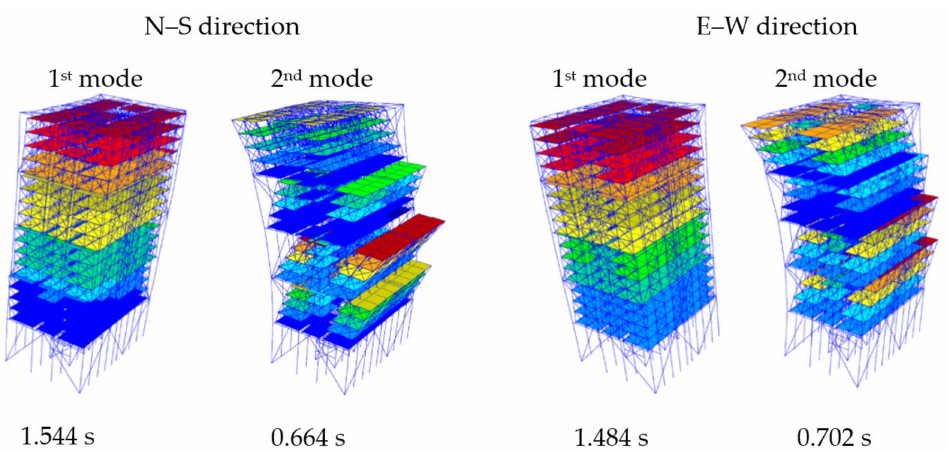
Figure 9. First mode shapes of the glulam concept with the modular substructures connected to the hyperfloors. Scale ratio of 10. Periods of the modes are under the